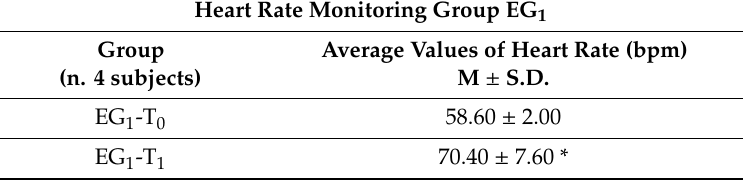
Table 4. Average values (Mean ± S.D.) of the heart rate, expressed in beats / minute (bpm) of Sardinian donkeys (experimental group EG 1 ).